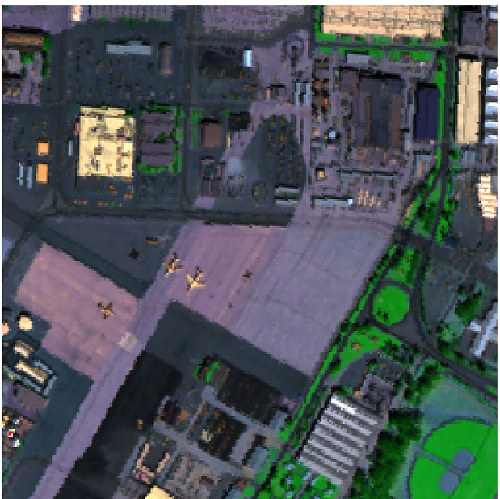
Figure 5. The RGB color image of the original multispectral data used in this paper.